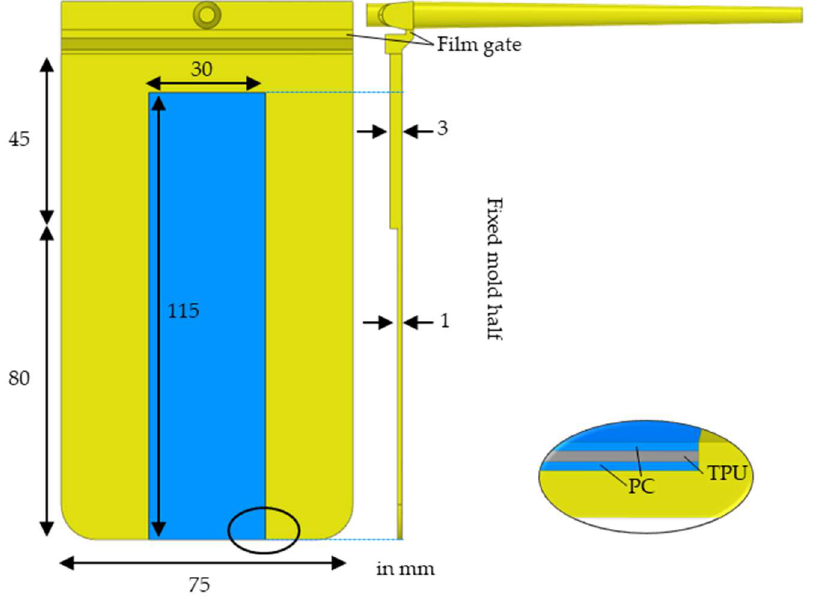
Figure 4. CAD of the stepped plate mold with dimensions. The film is placed on the fixed mold half as illustrated by the blue rectangle. The inset shows the film as modeled in AMI comprising PC